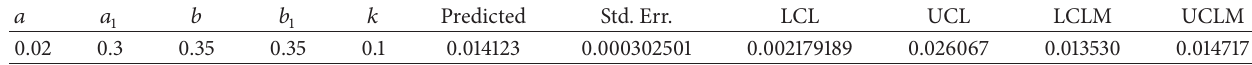
Table 11: The GLM procedure results for sampling